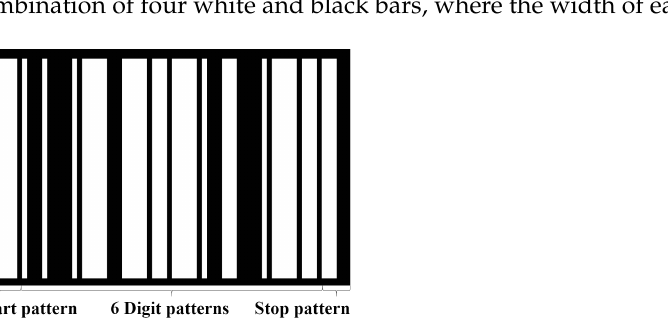
Figure 7. Barcode structure and example. Encoded number: